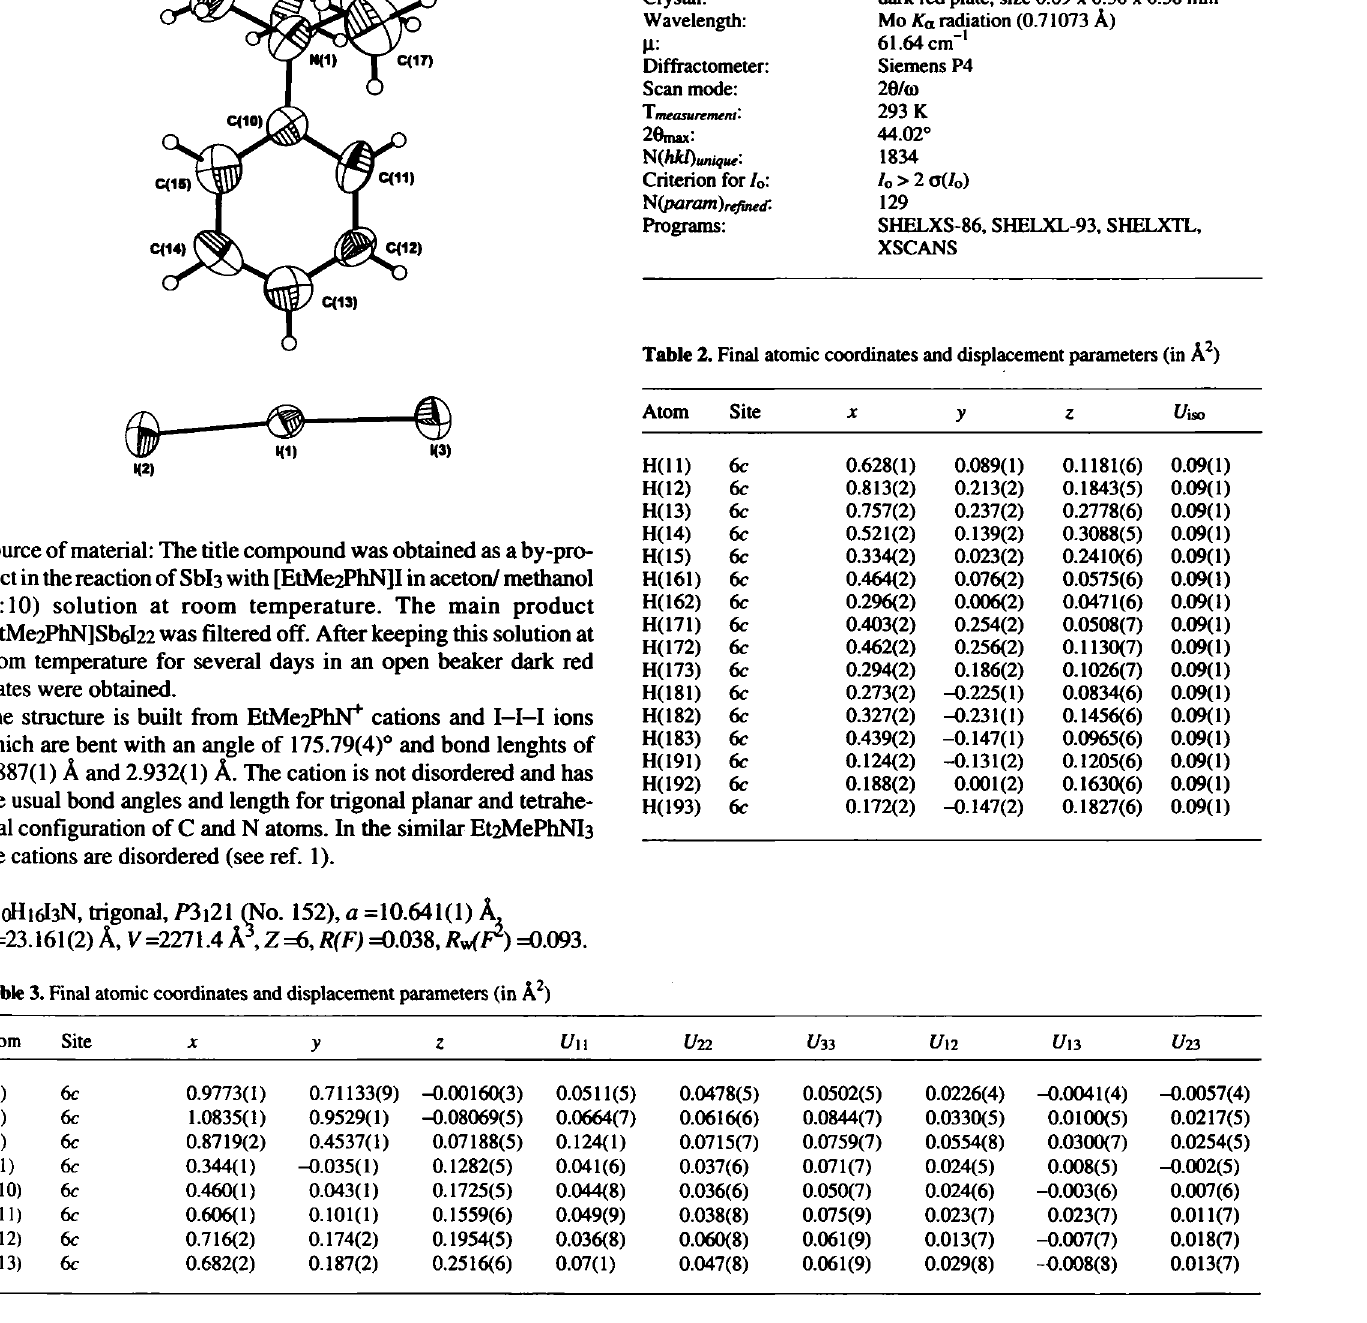
Table 2. Final atomic coordinates and displacement parameters (in